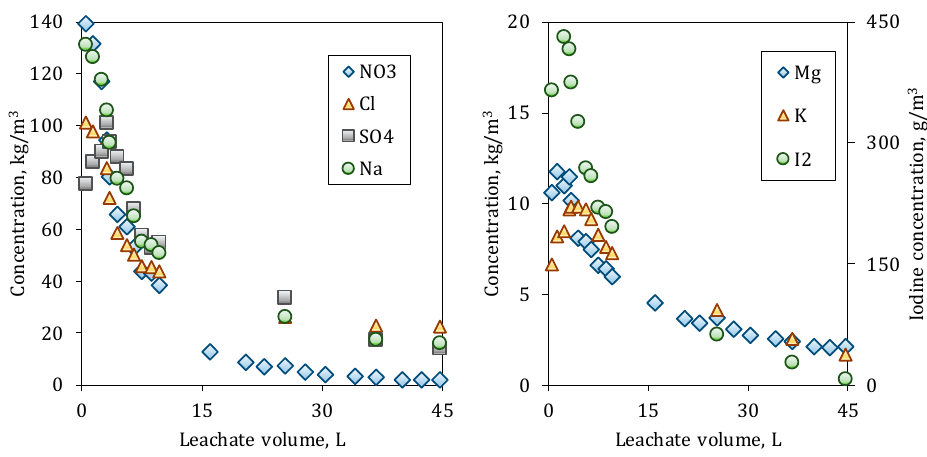
Figure 5. Outlet concentrations of the soluble species during leaching of the C20 column.